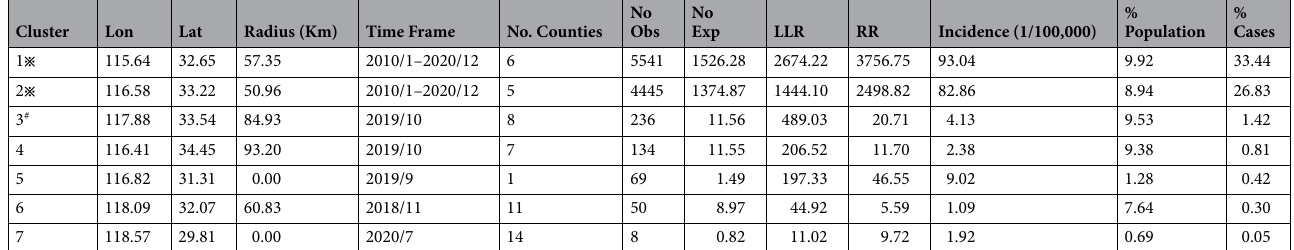
Table 4. Spatiotemporal clusters of scrub typhus detected using Kulldoff’s space–time scan statistic in Anhui, China, 2010–2020. No. Counties, number of counties within clusters; No. Obs, number of observed cases; No. Exp, number of expected cases; LLR, log likelihood ratio; RR, relative risk of the cluster compared with the rest of the country; %, the proportion of the population or cases in cluster to the total during the clustering time. Significant clusters with P < 0.05. ※ 1: Primary cluster. # 3–7: Secondary clusters.